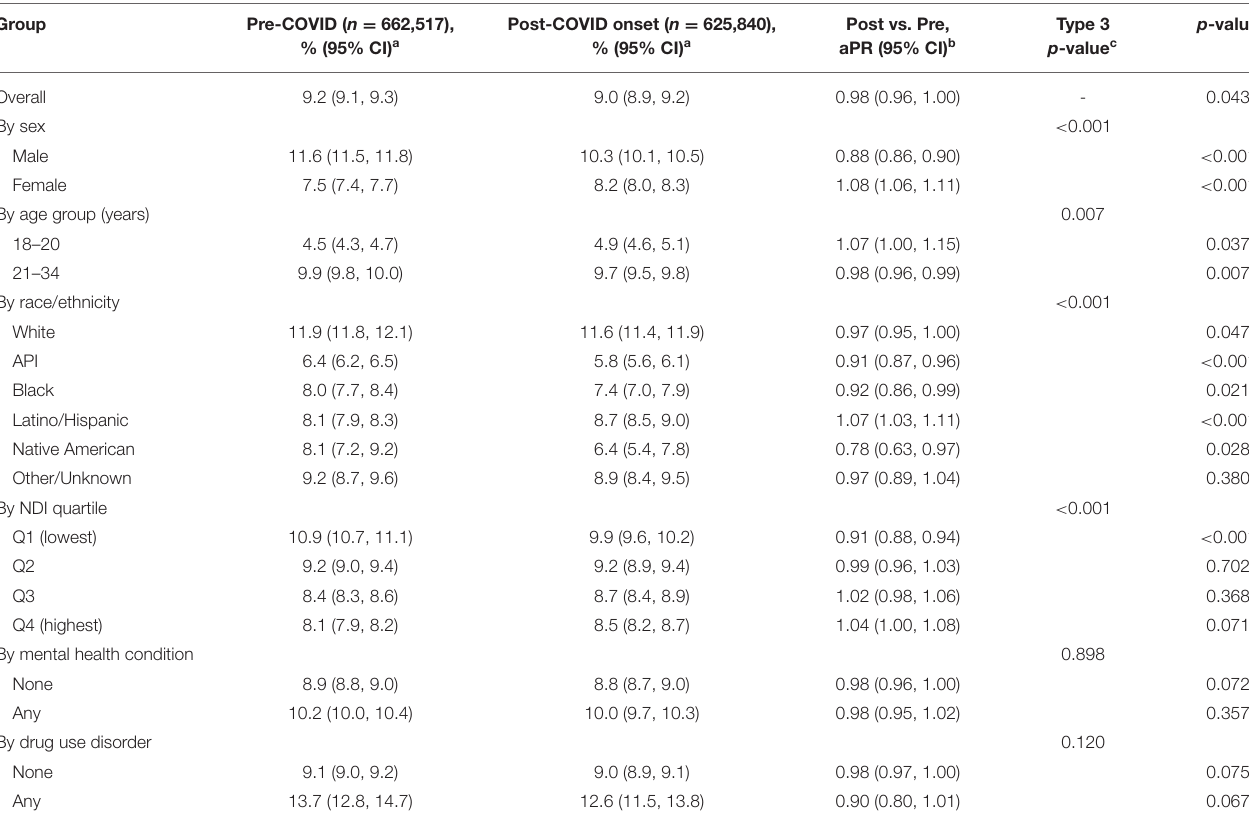
TABLE 2 | Unadjusted prevalence and adjusted prevalence ratios (aPR) of unhealthy alcohol use, overall and by patient characteristics, among young adult KPNC members who were screened, weighted by IPW.